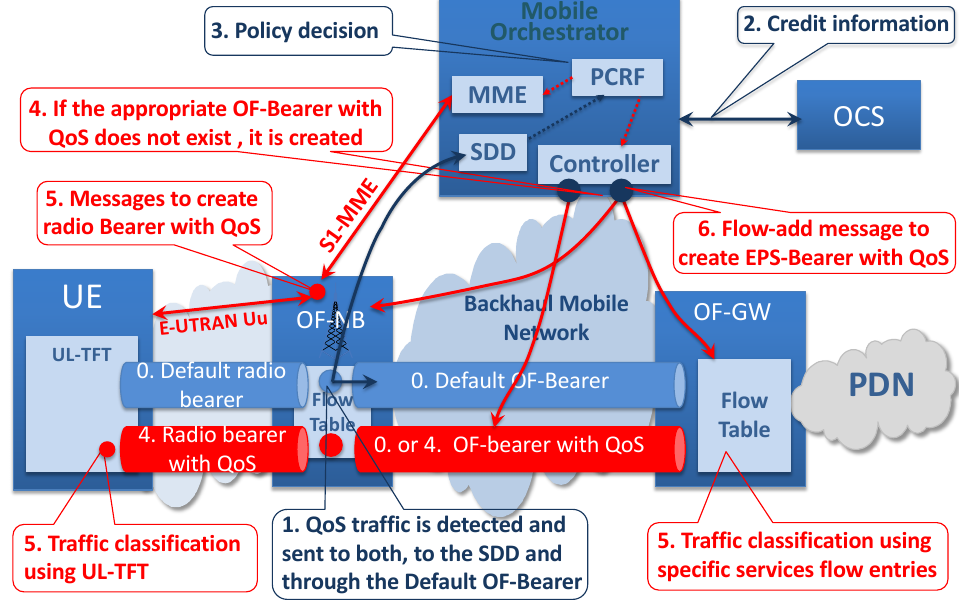
Figure 6. EPS-Bearer with QoS creation. UL-TFT, Uplink Traffic Flow Template; OCS, Online Charging